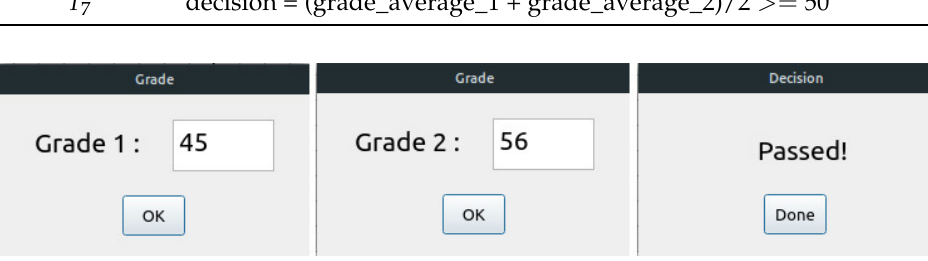
Figure 8. The sequential execution of the grading example after the reconfiguration.